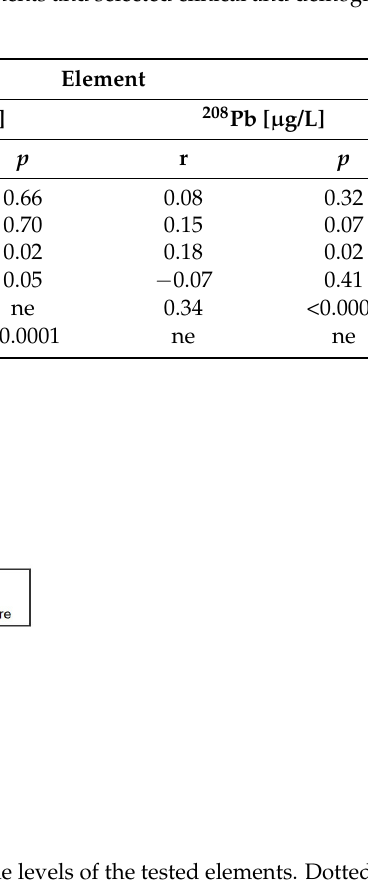
Table 5. Relationships between sociodemographic data and the levels of the tested elements.